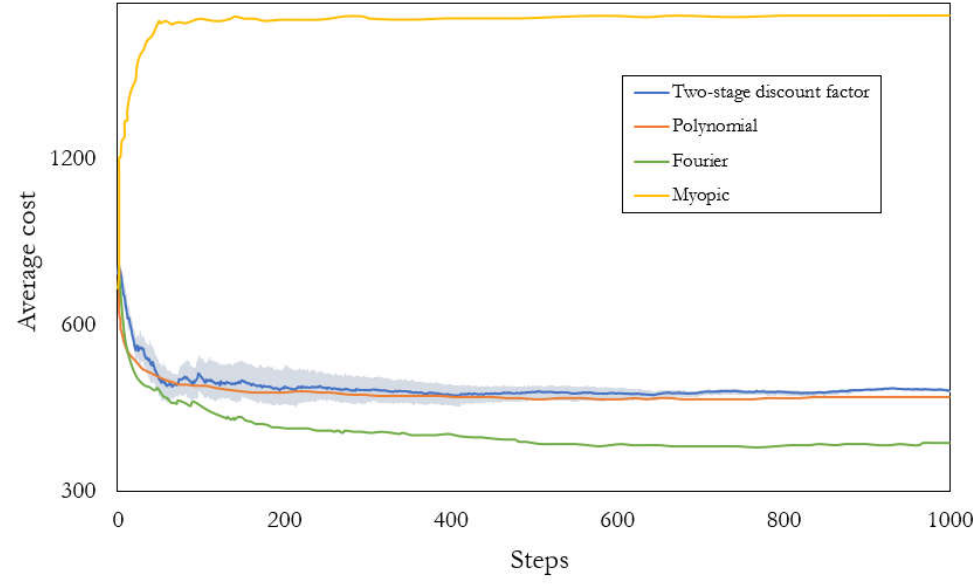
Figure 8. Average cost over 10 simulations for 1000 steps (log scale) for our proposed model (blue line), the polynomial (orange line), Fourier (green line), and myopic policy (yellow line) models [7]. Bands represent 95% bootstrap confidence intervals for 10 simulations.